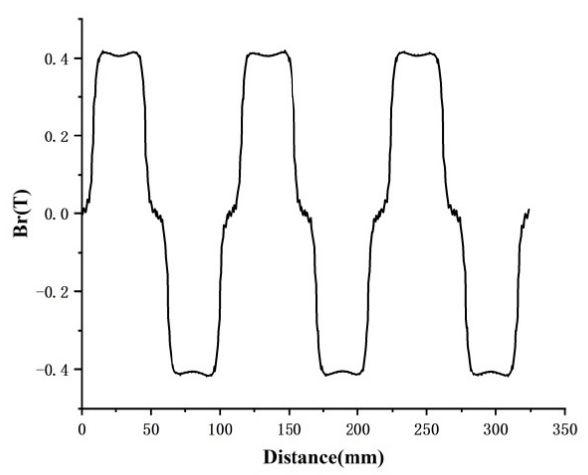
Figure 7. Radial air gap magnetic density component.